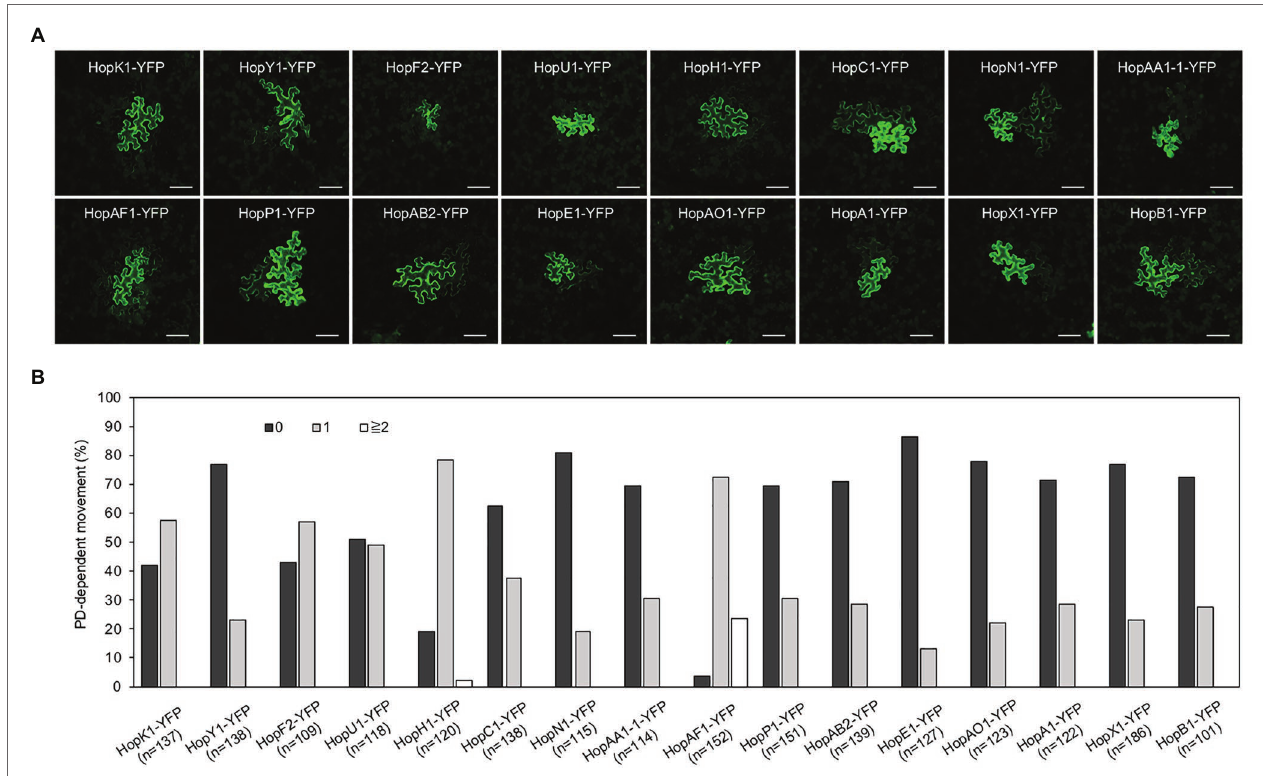
FIGURE 1 | The movement of bacterial effectors between plant cells. (A) Confocal images show the diffusion of effector-yellow fluorescent protein (YFP) fusion proteins. Images were taken from epidermis of Nicotiana benthamiana leaves. An agrobacterium-mediated protein movement assay was conducted to determine the movement of effector-YFP fusion proteins in plants. The transformed plant cell exhibits strong yellow fluorescent (YFP) signals. The movement of the fusion proteins is determined by the detection of YFP signals in cells surrounding the transformed cell. Scale bars = 100 μ m. (B) Quantitative data show the percentage of transformation events resulting in no diffusion (0), one cell layer diffusion (1), and two or more than 2 cell layers diffusion ( ≧ 2). The data shown here are pooled from at least three biological replicates. The number of transformation events analyzed is indicated